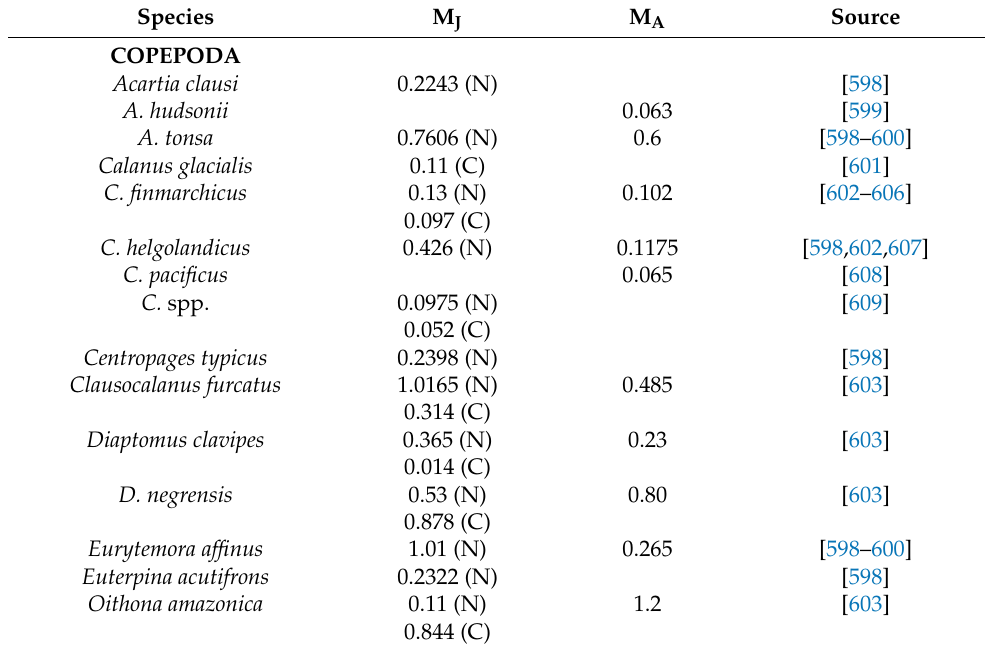
Table A3. Instantaneous natural mortality rates (d − 1 ) 1 of larval juveniles (M J ) and adults (M A ) of copepod and decapod